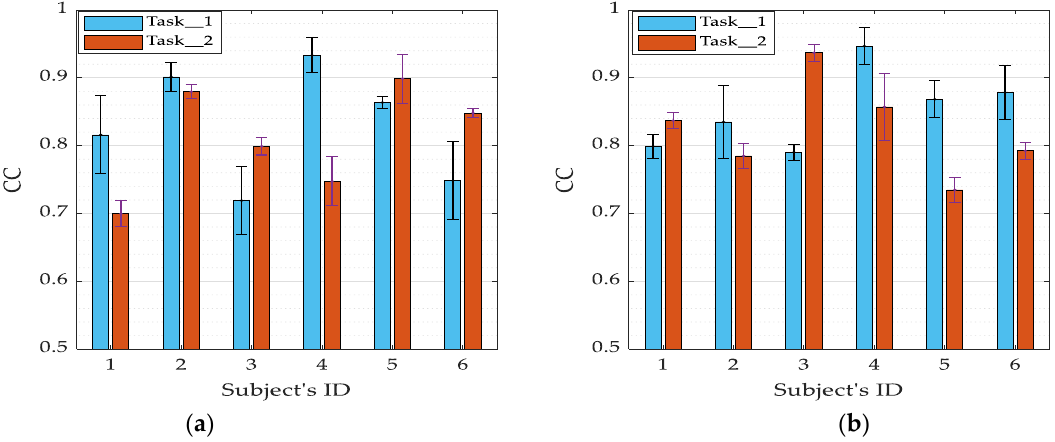
Figure 11. Prediction performance across subjects in terms of CC index. ( a ) Performance for slow-motion; ( b ) performance for quick motion.